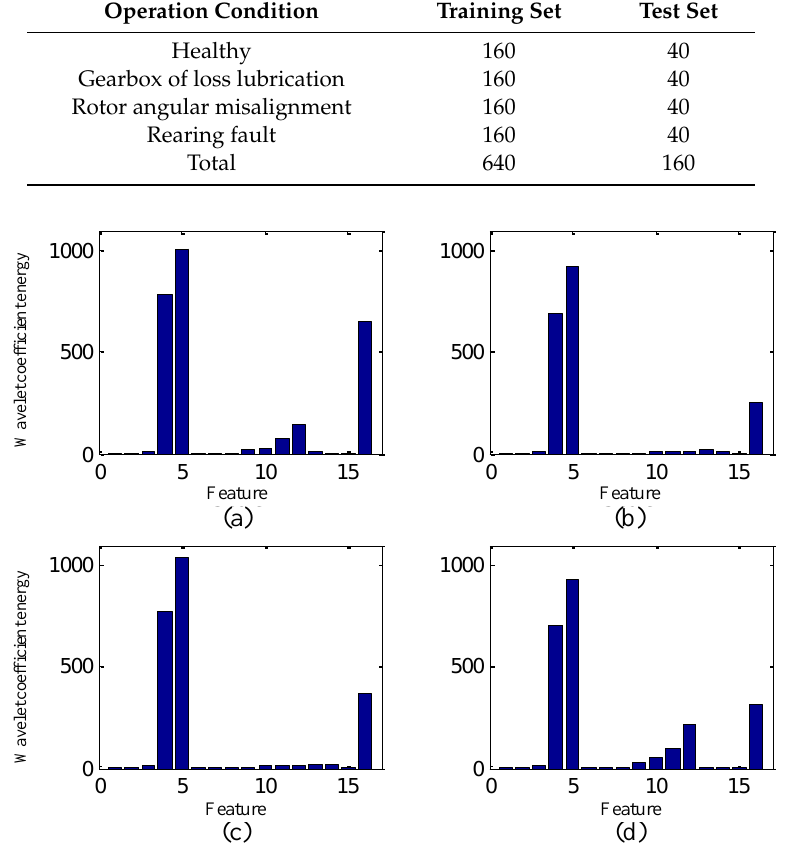
Table 1. The state distribution of training set and test set.